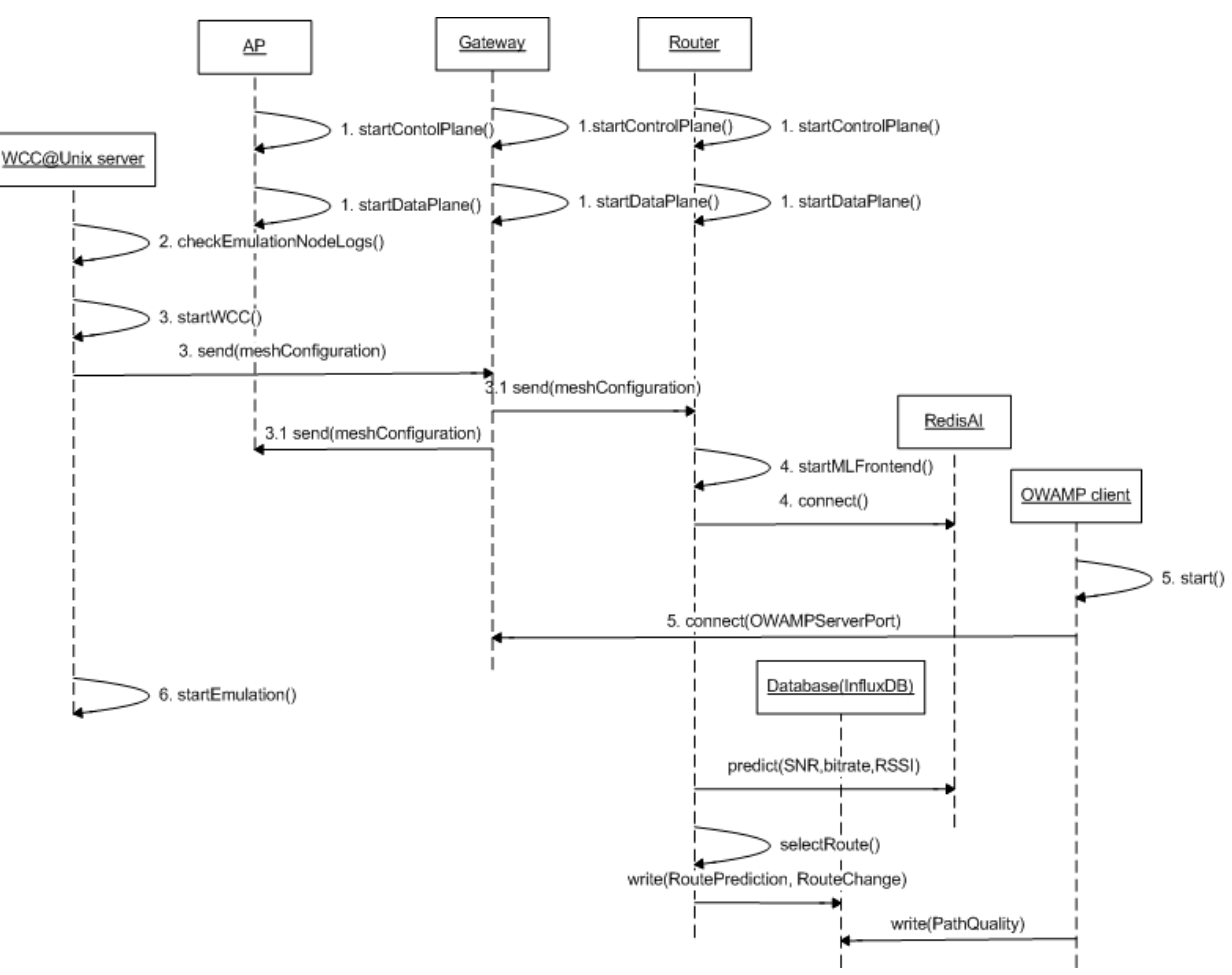
Figure A1. Sequence diagram of test stages for OWD measurement in the emulator.